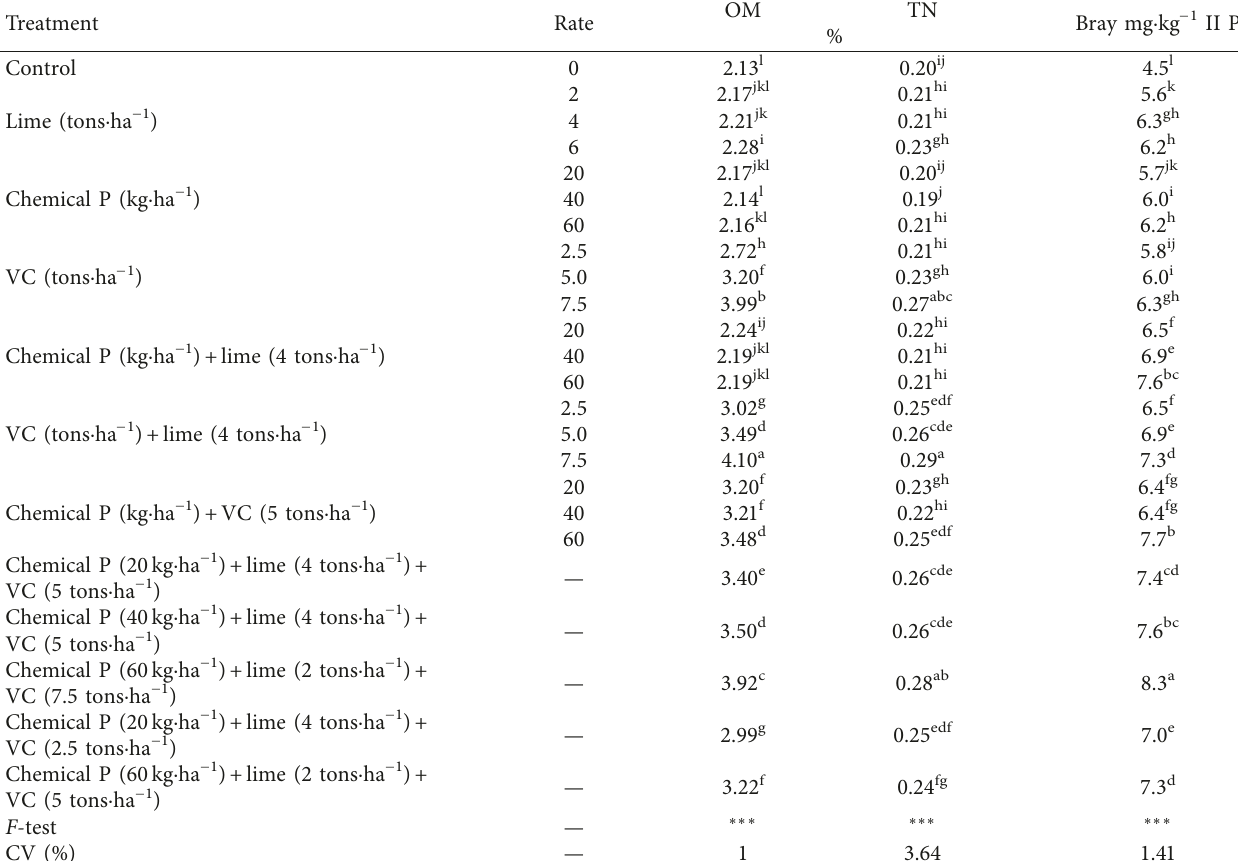
Table 5: Effects of treatments on organic matter, total nitrogen, and available phosphorus of the soil after incubation.